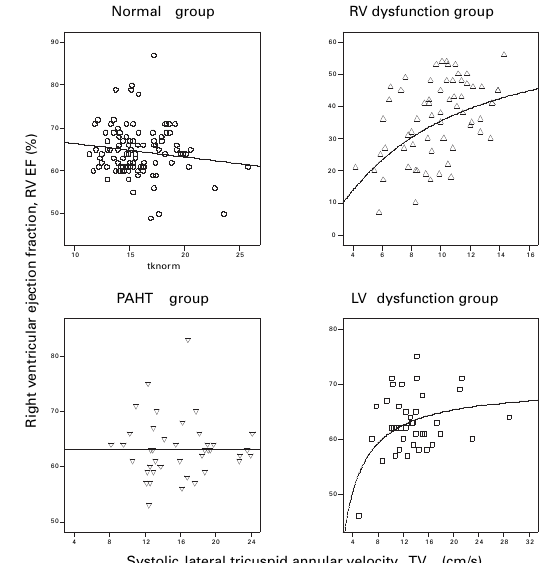
Figure 5 Receiver operating characteristic (ROC) analysis curves for the distinction using lateral tricuspid annular velocity (TV lat ) between normal and abnormal RV ejection fraction (RV EF <55%; left panel; area under the ROC curve = 0.896, 95% confidence interval = 0.850–0.942), and between mode- rately and severely reduced RV ejection fraction (RV EF<30%; right panel; area under the ROC curve = 0.805, 95% confi- dence interval = 0.700–0.910).